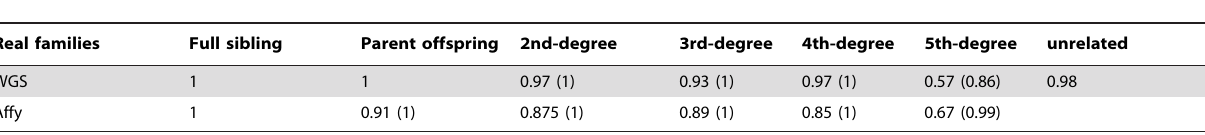
Table 1. Fraction of correct predictions for real families.